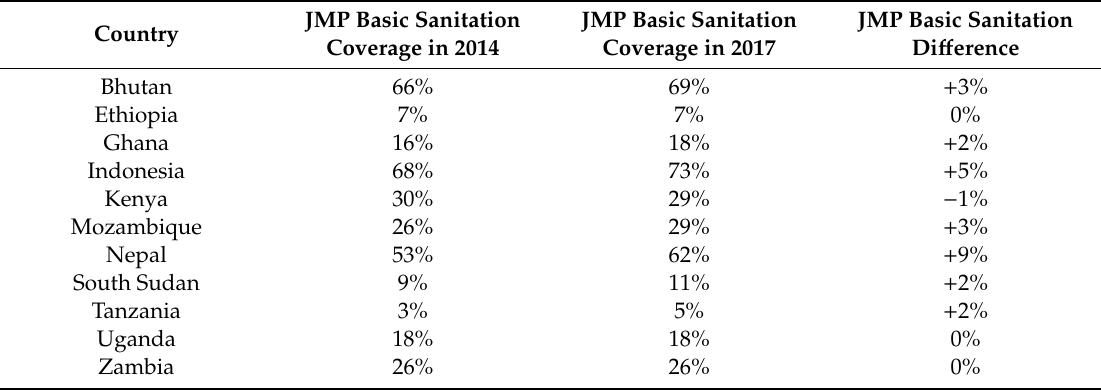
Table 3. Joint Monitoring Program for Water Supply and (JMP) reported change in coverage of basic sanitation, shown by country.